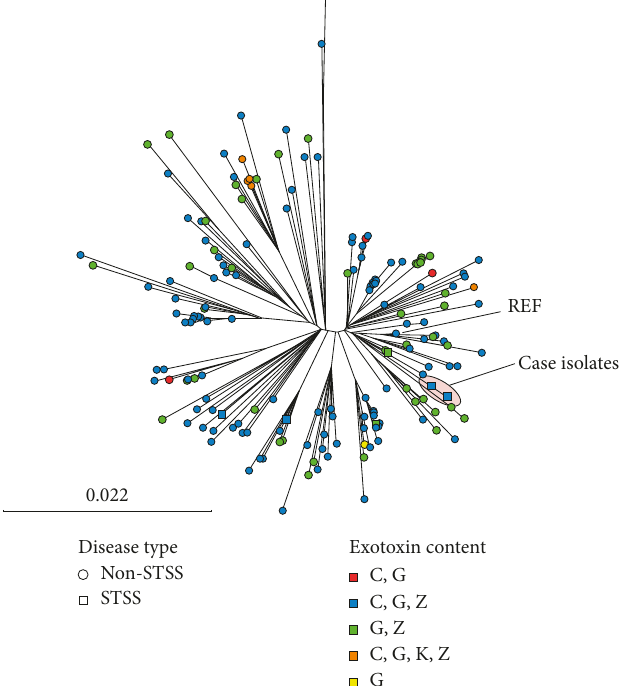
Figure 2: Neighbor-joining phylogenetic tree based on 2,464 unique, core genome biallelic single nucleotide (SNP) differences relative to the reference, MGAS27061, between case (circled) and CDC-sequenced emm89 iGAS strains from 2015 [4]. GAS isolates from cases of toxic shock are depicted by boxes including 2 from the 2015 CDC-sequenced strains and 2 previously described isolates from Houston, TX.